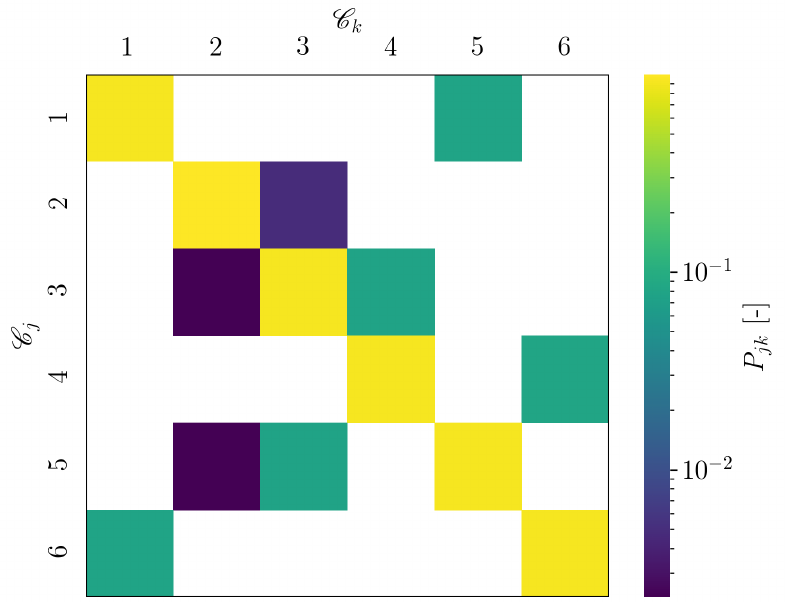
Figure 9. Visualization of the cluster transition matrix (CTM). Transition occurs from cluster C k to cluster C j